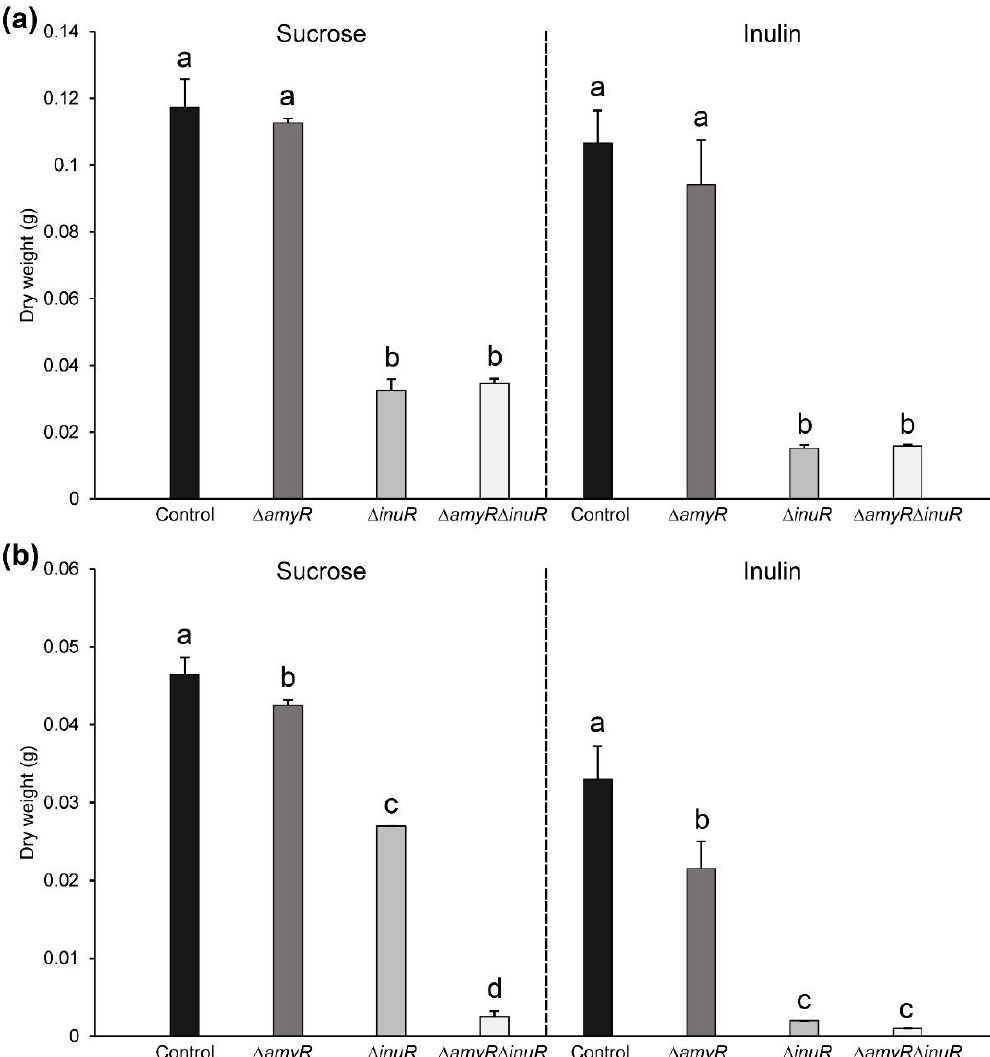
Figure 3. Mycelial dry weight measurement results of A. niger control (CBS 138852), ∆ amyR , ∆ inuR and ∆ amyR ∆ inuR strains grown on liquid ( a ) or solid ( b ) medium containing 1% sucrose or inulin as carbon source, supplemented with 1.22 g/L uridine and 5 mM D-fructose to facilitate initial germination of fungal conidia. Liquid culture triplicates were incubated for 48 h in a rotary shaker at 250 rpm and 30 °C, while solid medium cultures were grown for 7 days at 30 °C. Samples showing different letters (a – d) show statistically significant differences among the strains (ANOVA and Tukey HSD test, p < 0.05).